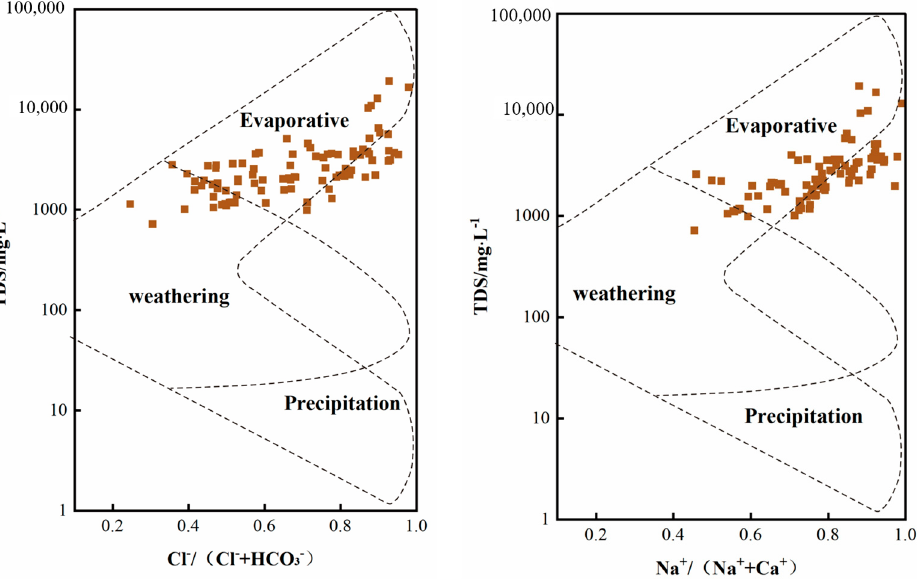
Figure 7. Gibbs diagram of groundwater in the study area.